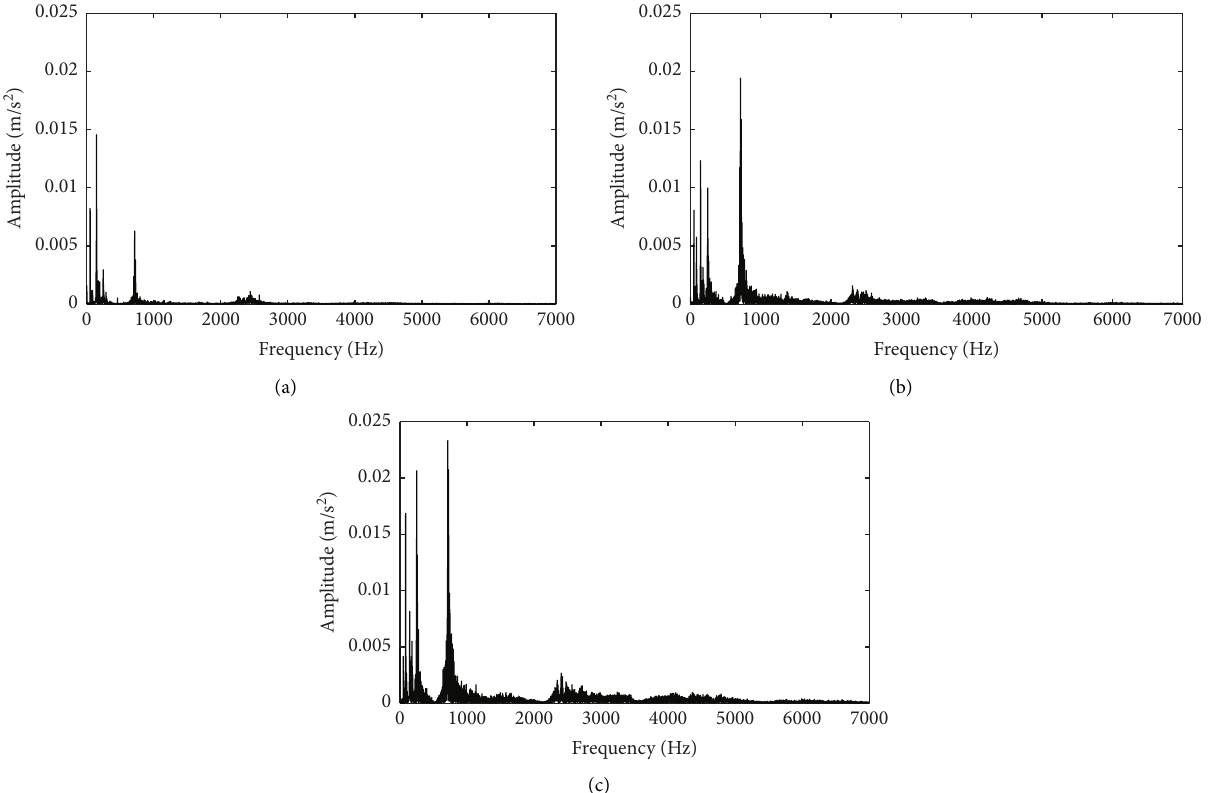
Figure 4: Spectrum diagram of the vibration signal in different lubrication states. (a) Mixed lubrication (20 th min), (b) boundary lubrication (60 th min), and (c) dry friction (80 th